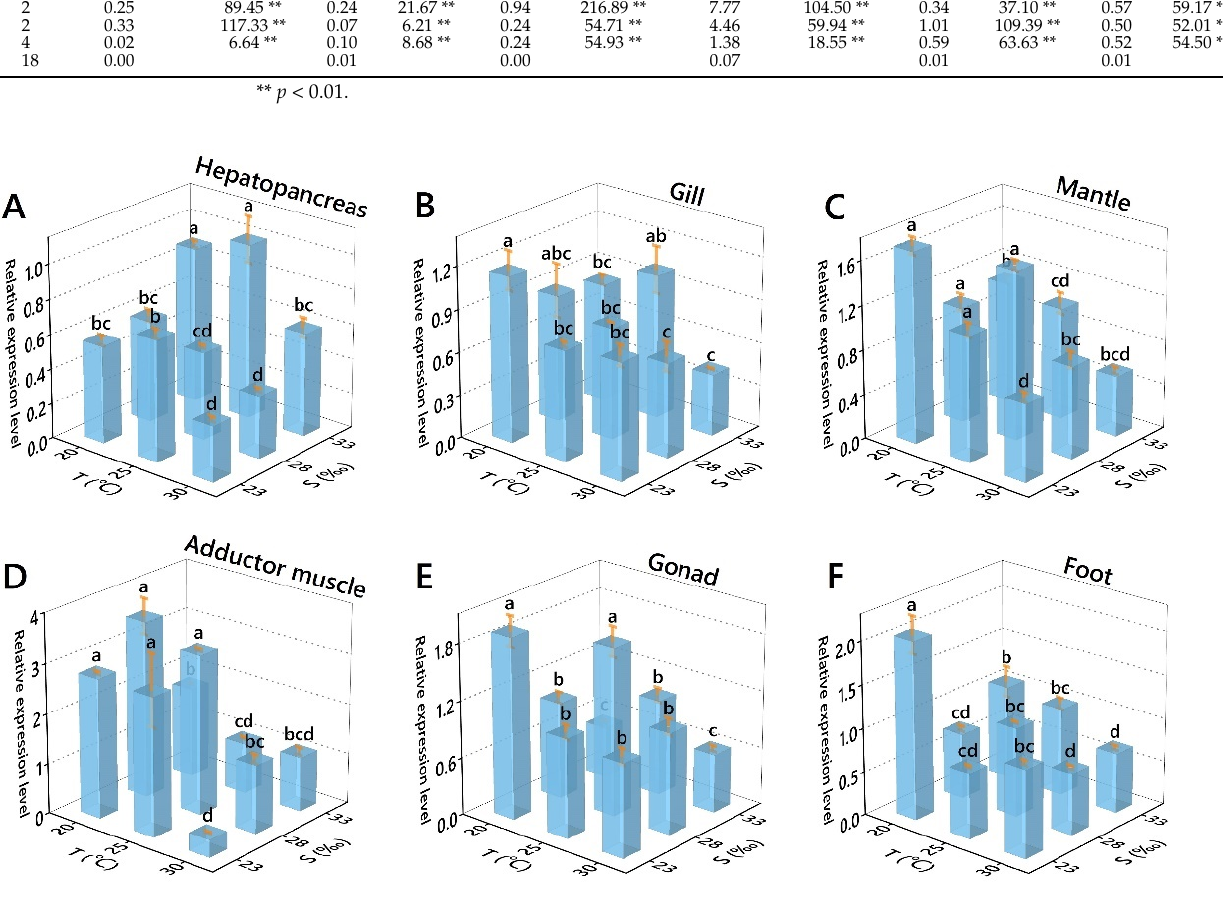
Figure 3. Effects of temperature and salinity on the SOD relative expression level of Perna viridis in different tissues. (( A ) Hepatopancrear; ( B ) Gill; ( C ) Mantle; ( D ) Adductor muscle; ( E ) Gonad; ( F ) Foot). Different letters indicate significant differences ( p < 0.05). Both single factor and combined effects of salinity and temperature significantly impacted the relative expression level of GPX, except for salinity-mantle (Table 6). The relative expression levels of GPX in hepatopancreas decreased with increasing temperature. They decreased then increased with increasing salinity, with the maximum value occurring at 25 ◦ C/33‰ and the minimum value at 30 ◦ C/28‰ (Figure 4A). The relative expression levels of GPX in gills increased then decreased with increasing temperature and salinity, except for 25 ◦ C/28‰, where there was an outward trend of increase, with the maximum value occurring at 30 ◦ C/23‰ and the minimum value at 30 ◦ C/28‰ (Figure 4B).